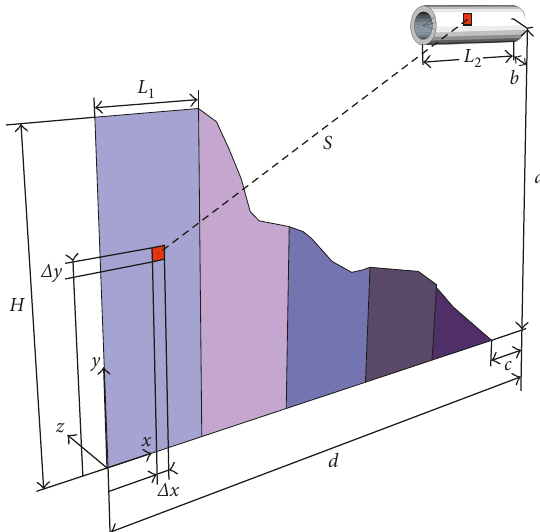
Figure 7: View factor for plane and cylinder